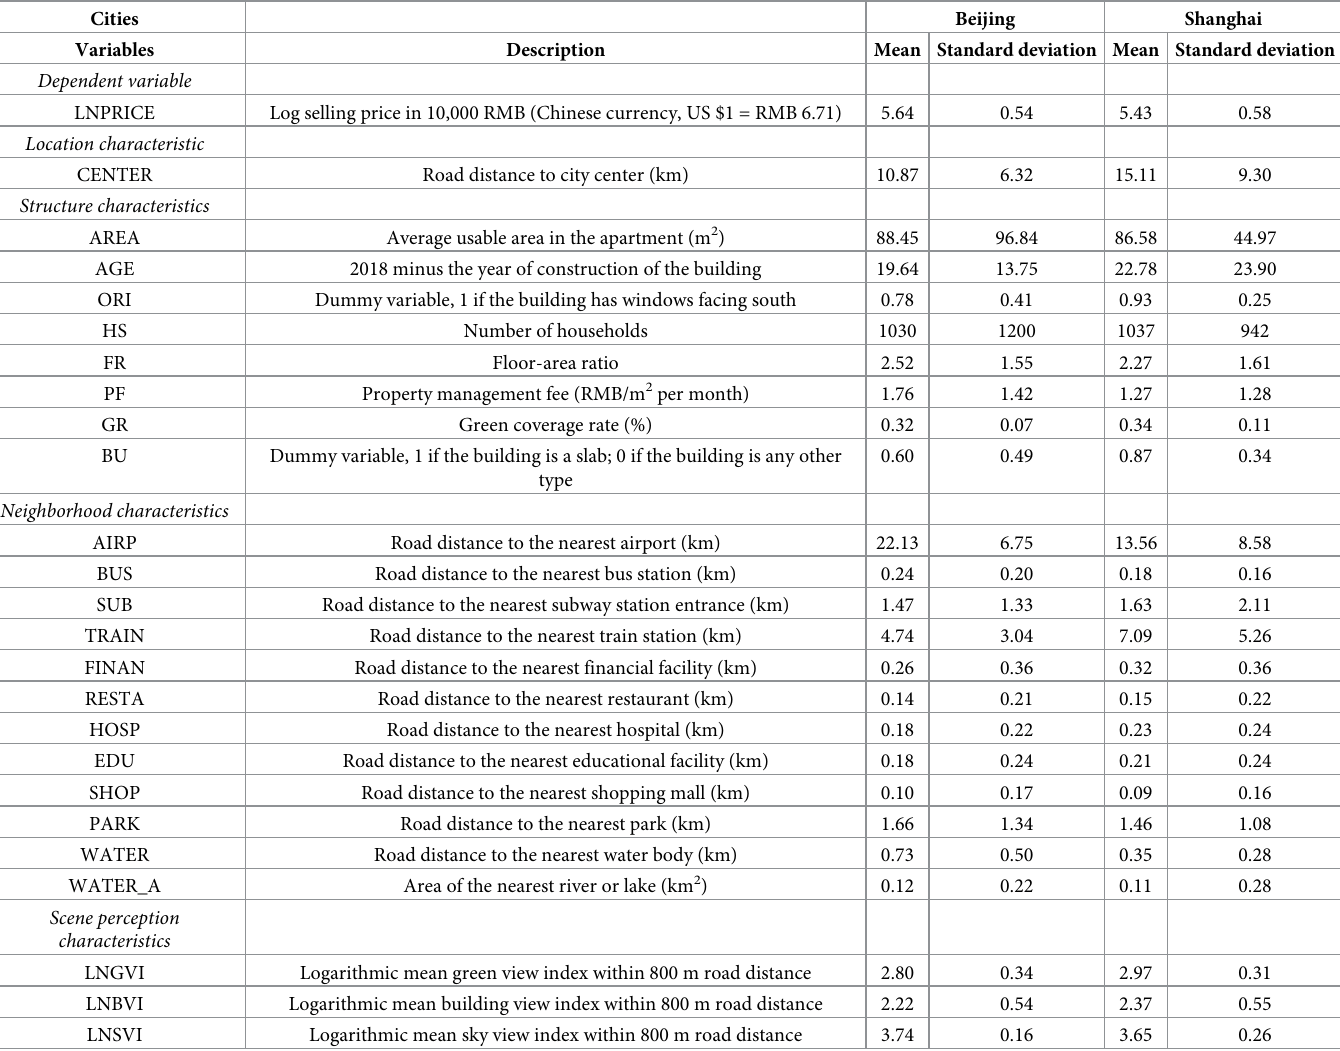
Table 1. Variable descriptions and basic statistical